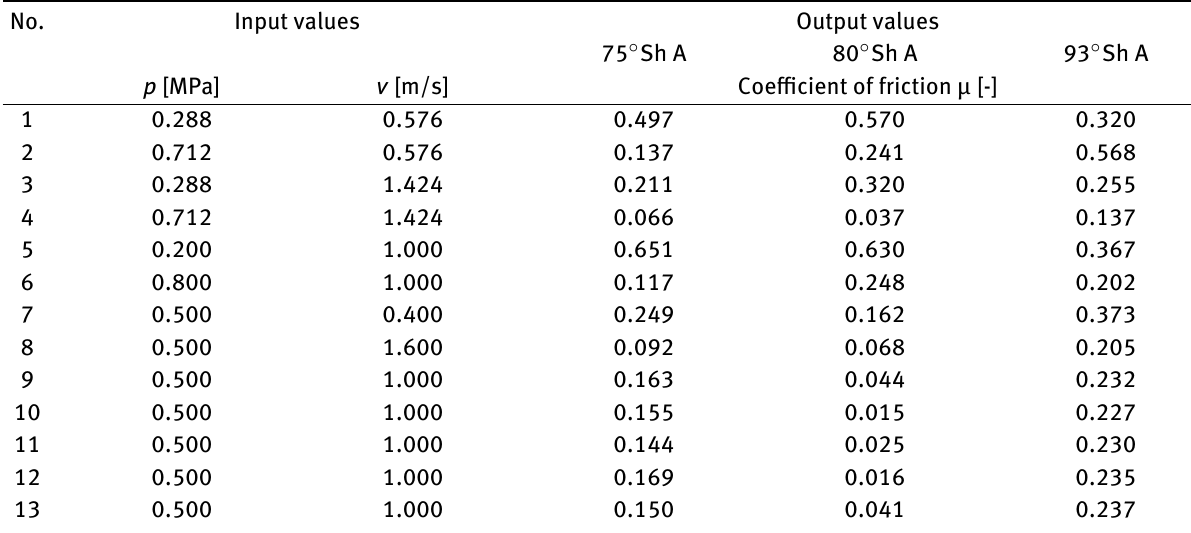
Table 1: Experimental plan and results of testing the coeflcient of friction of different hardnessEPUR. No. Input values Output values 75 ∘ Sh A 80 ∘ Sh